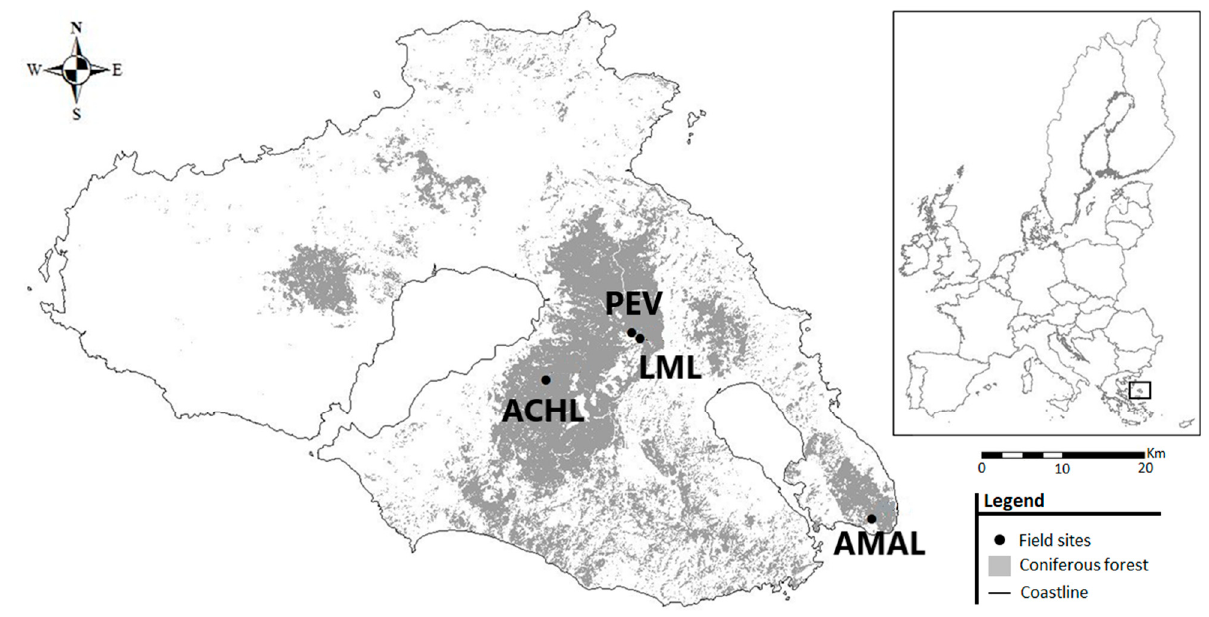
Figure 1. Distribution of the four study plots across the island of Lesvos. AMAL is the 13 year-old plot, PEV is the 40 year-old plot, LML is the 72 year-old plot and ACHL is the 92 year-old plot.